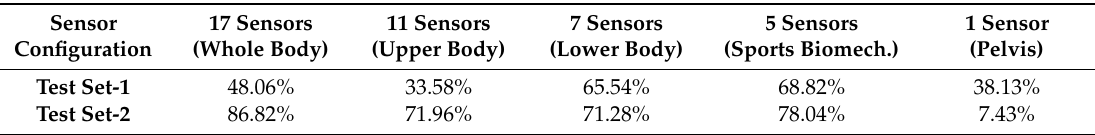
Table 21. Classification accuracies for test set-1 and test set-2 for the five different sensor configurations using the k-nearest neighbors